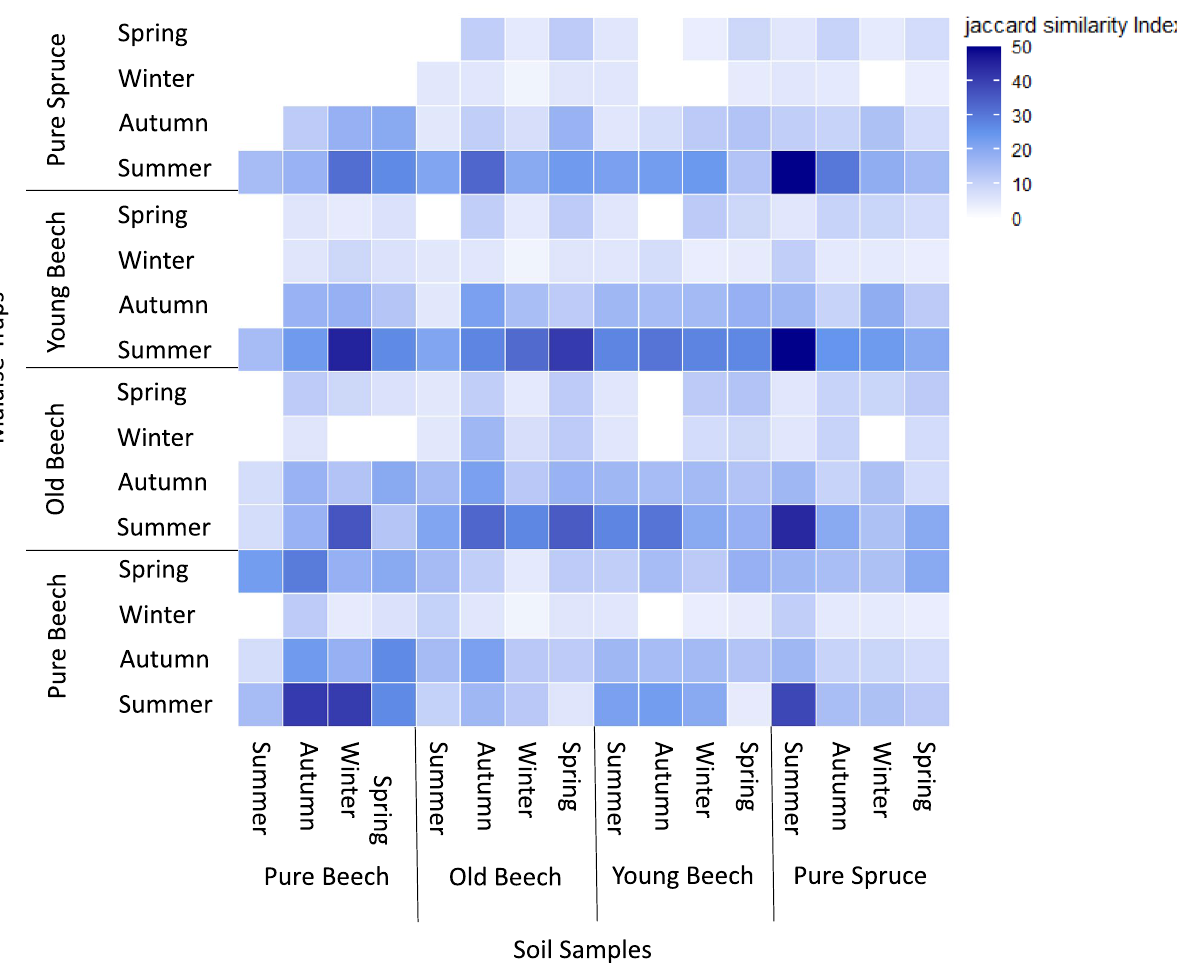
Figure 4. Heatmap showing similarity levels (Jaccard similarity index) between arthropod communities (blastID ≥ 99%) associated with each of the four forest types, for each sample type and season. Increasing similarities denoted by darker color.